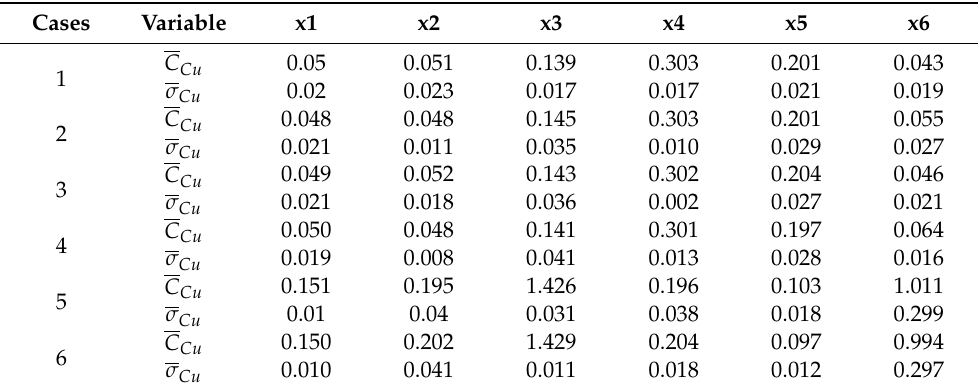
Table 5. Calculated mean concentration of Cu in scrap, C Cu , and its standard deviation, σ Cu , in six scrap types ( x j ) using the maximum likelihood method for nine